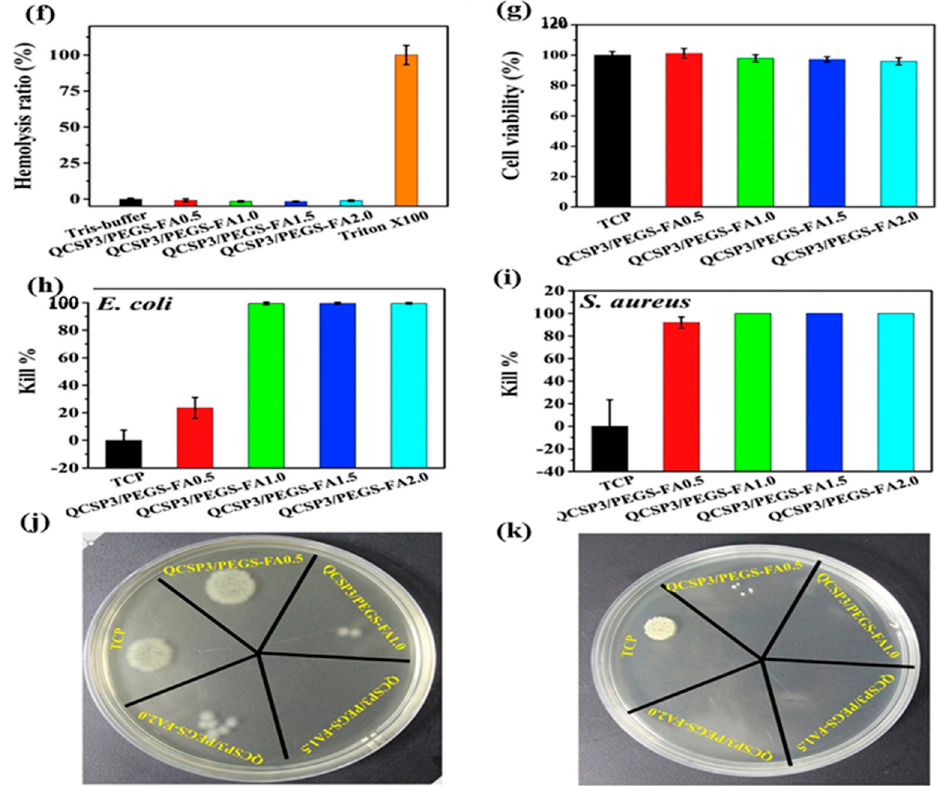
Figure 21. DPPH scavenging percentage by the hydrogels ( a ); weight ratio of the hydrogel in PBS at 37 °C for different time periods ( b ), rheological performance of the hydrogels ( c ), morphologies structure ( d ), self-healing property ( e ), anti-hemolytic ability ( f ), histocompatibility ( g ), antimicrobial activity ( h – k ) (adapted with permission from Zhao et al., 2017).